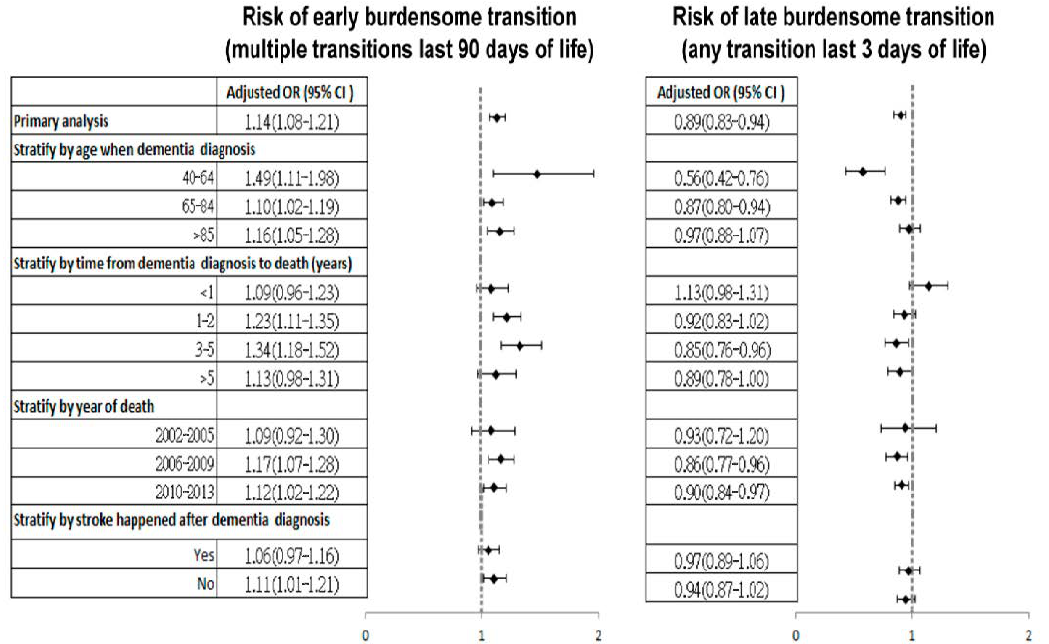
Table 2. Subgroup analysis of burdensome end-of-life transition in people with dementia who